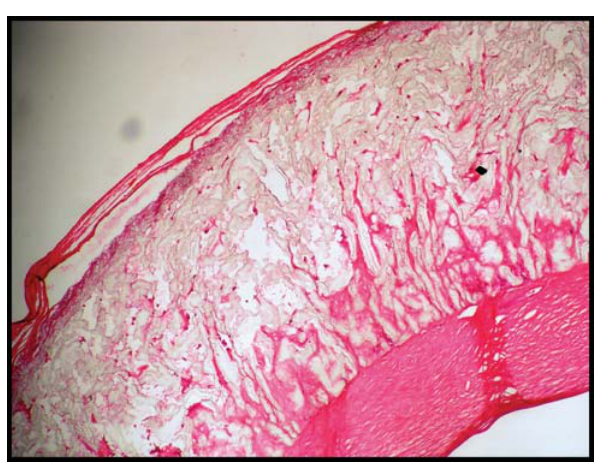
FIGURE 4 - Invasion of e-PTFE patch by fibroblasts and chronic inflammatory reaction in the outer surface. Fibrosis in the inner